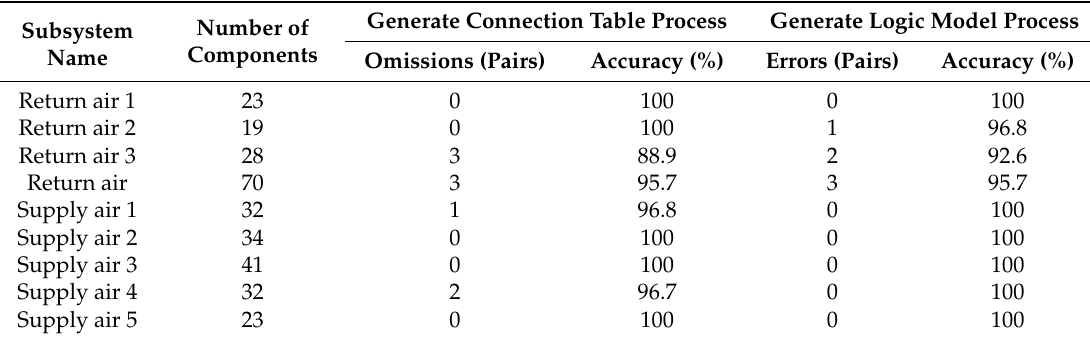
Table 6. Performance of the algorithms developed for generating MEP logic models.